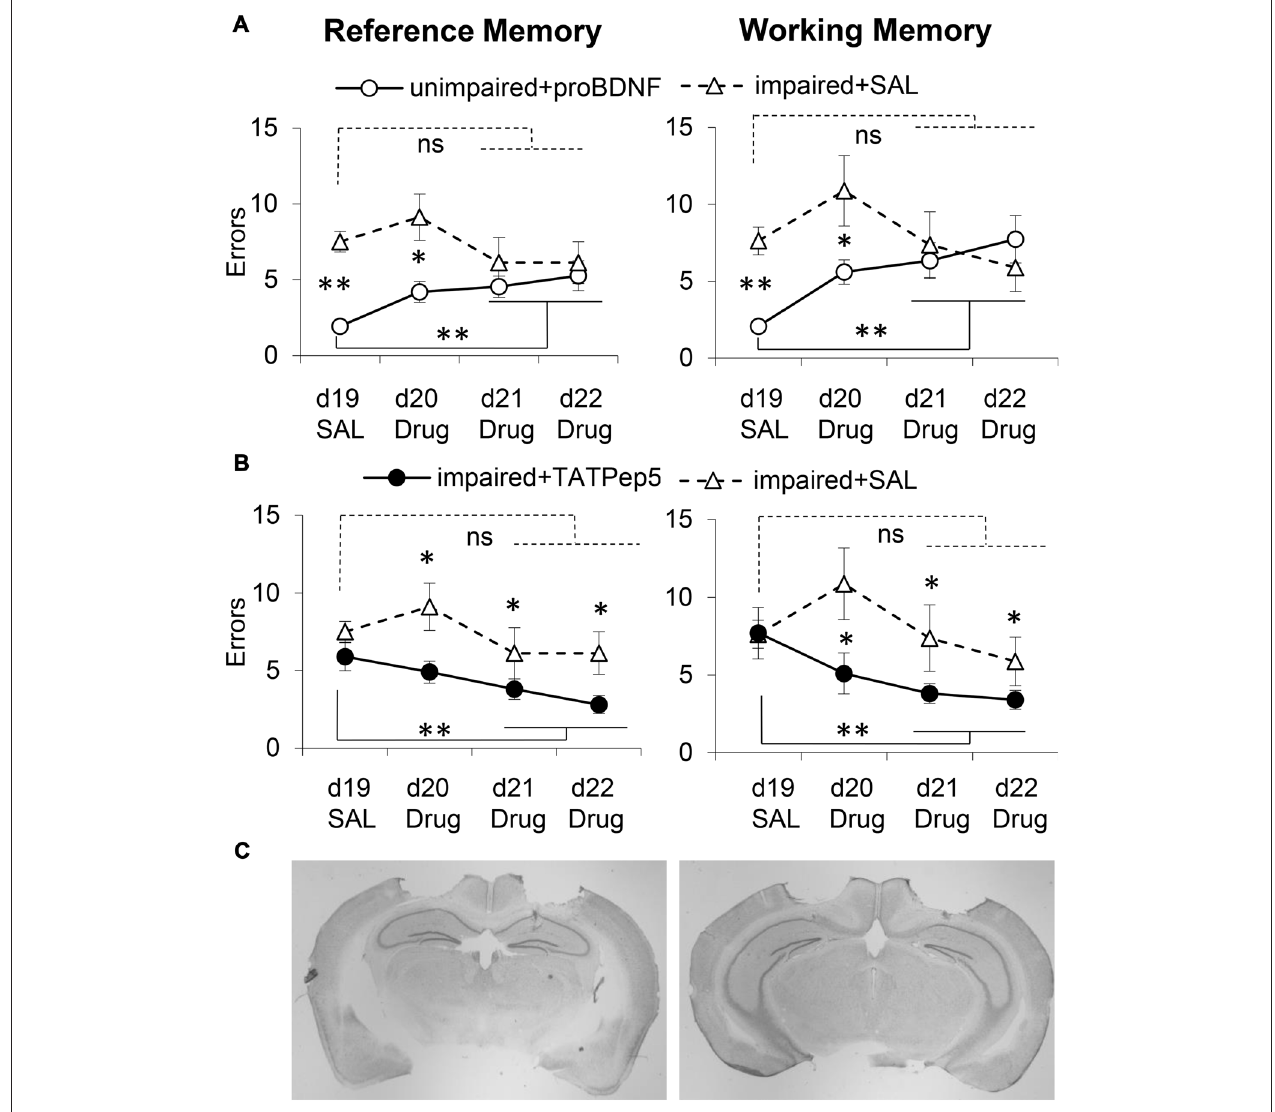
FIGURE 3 | Intra-hippocampal infusion of proBDNF impairs memory in well-performing (unimpaired) mice, while TAT-Pep5 infusion improves memory in poorly-performing (impaired) mice. (A) Average ( ± SEM) RM and WM errors in memory impaired 18-month old mice receiving intra-hippocampal saline infusions (impaired + SAL, n = 8, open triangles) and well-performing 18-month old aged mice receiving uncleavable proBDNF intra-hippocampal infusions (unimpaired + proBDNF, n = 16, open circles) over four daily sessions of a WRAM task. (B) Average ( ± SEM) RM and WM errors in memory impaired 18-month old mice infused with saline (impaired + SAL, n = 8, open triangles) and memory impaired 18-month old mice receiving intra-hippocampal infusions of TAT-Pep5 (impaired + TAT-Pep5, n = 9, closed circles) over four daily sessions of a WRAM task. (C) Representative images indicating the locations of drug infusions at two levels of the hippocampus. ns not significant; ∗ p < 0.05; ∗∗ p <